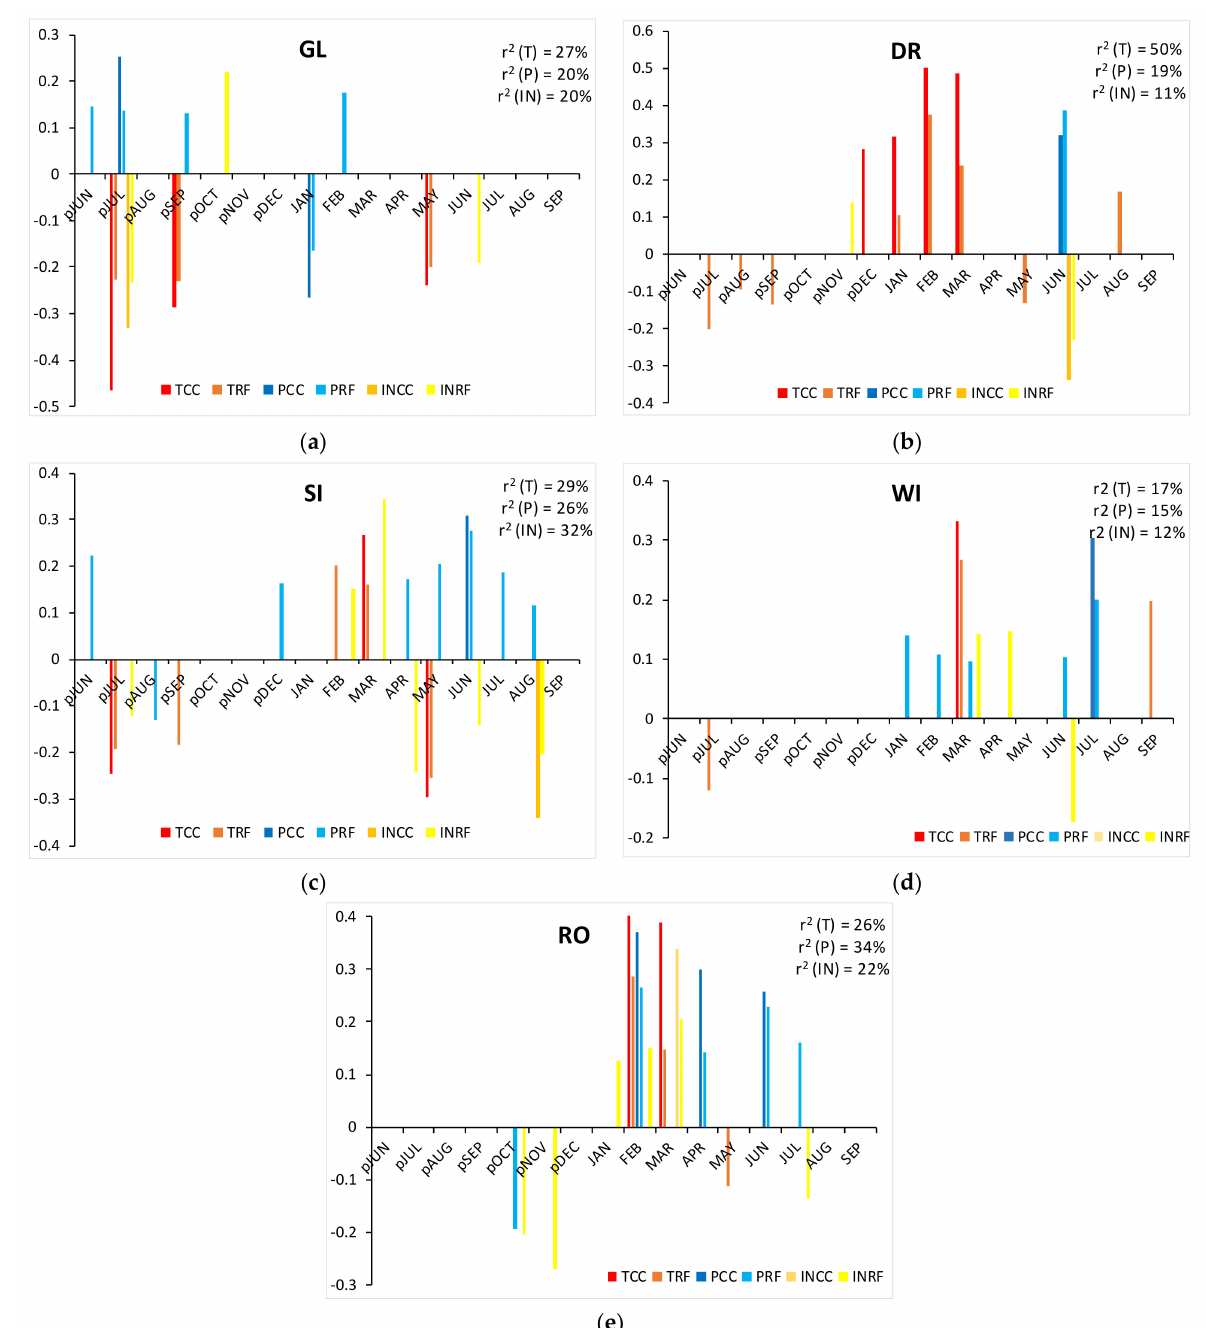
Figure 5. Results of correlation (CC) and response function (RF) analyses for Sawara cypress chronologies in ( a ) Glinna, ( b ) Drawsko, ( c ) Sierak ó w, ( d ) Wirty, ( e ) Rog ó w for temperature (T), precipitation (P) and insolation (IN). Bars denote significant values ( p ≤ 0.05); p, preceding year; r 2 , multiple regression determination